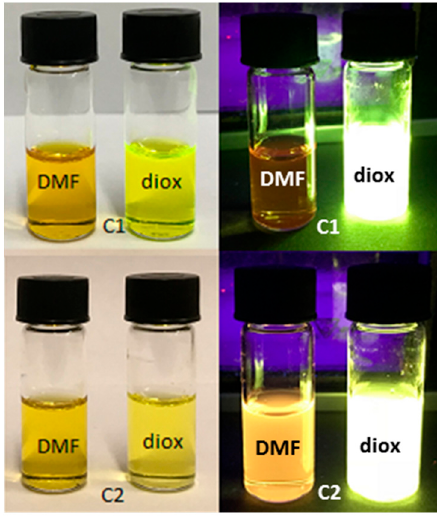
Figure 2. Fluorophores solutions (10%) in DMF ( left ) and dioxane ( right ) in natural (left column) and under 375 nm UV light (right column).